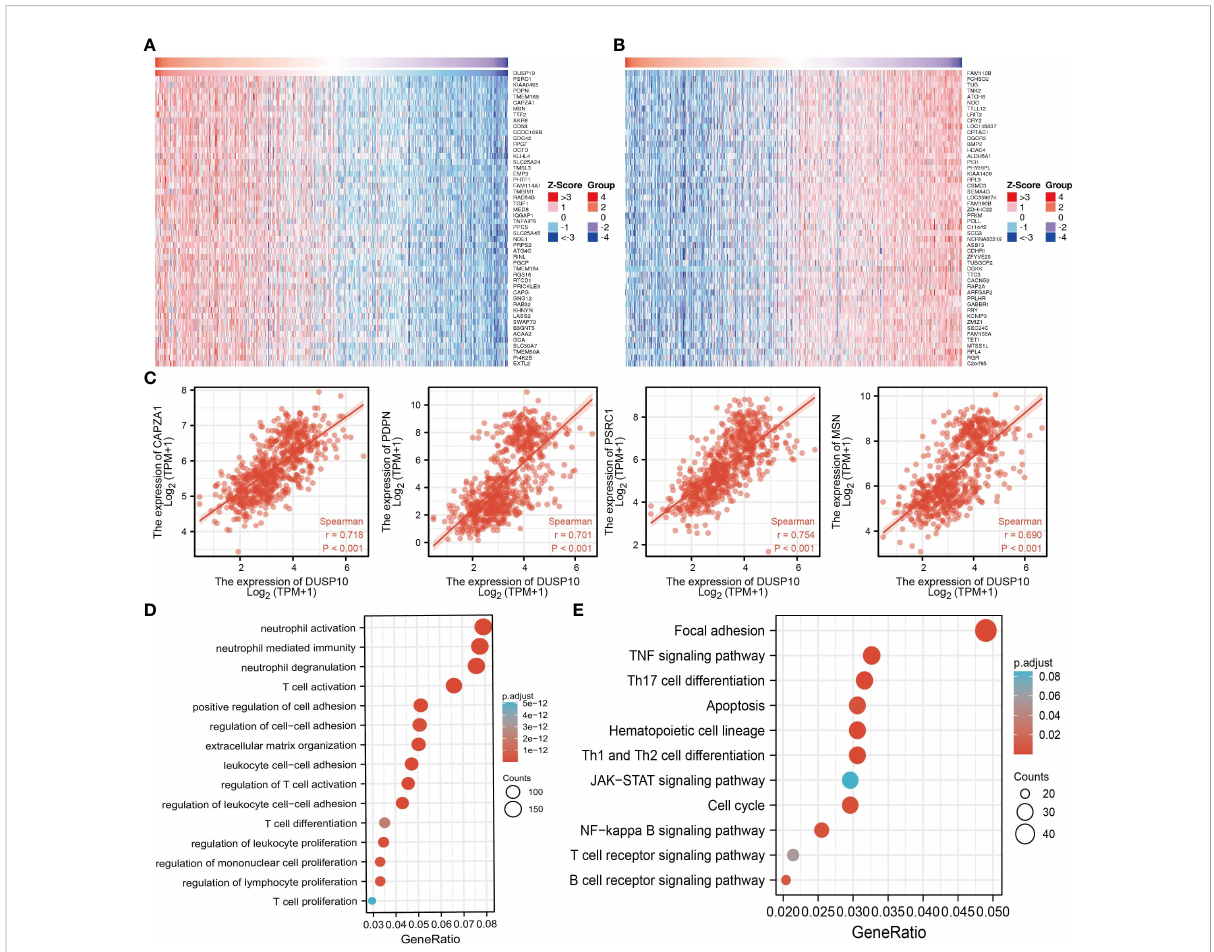
FIGURE 6 Functional analysis of DEGs between the high and low DUSP10 expression groups in TCGA dataset. (A, B) Heatmaps of the differentially expressed genes between the high and low DUSP10 expression groups. (C) The top eight coexpressed genes of DUSP10 were selected, and correlation analysis was performed in the online database. (D, E) GO and KEGG enrichment analyses of the high and low DUSP10 expression groups in TCGA dataset. DEGs, differentially expressed genes; TCGA, The Cancer Genome Atlas; GO, Gene Ontology; KEGG, Kyoto Encyclopedia of Genes and